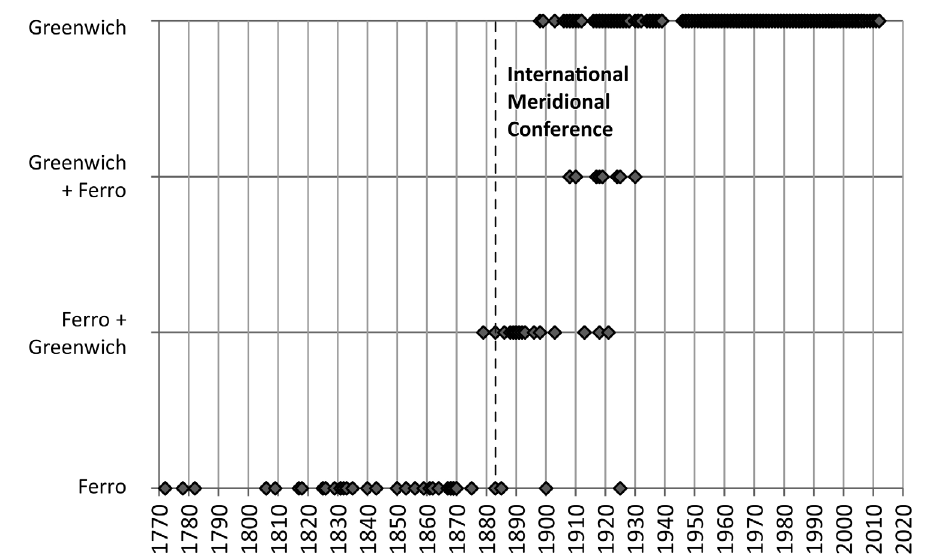
Fig. 1. The publications of the Polish school atlases according to the Prime Meridian used in them (the only case of using the Warsaw Meridian, 1908, is not taken into account). The Paris Meridian is included in the Ferro longitude system. If two meridians are indicated, one of them, predominating in the atlas, is the first one to be